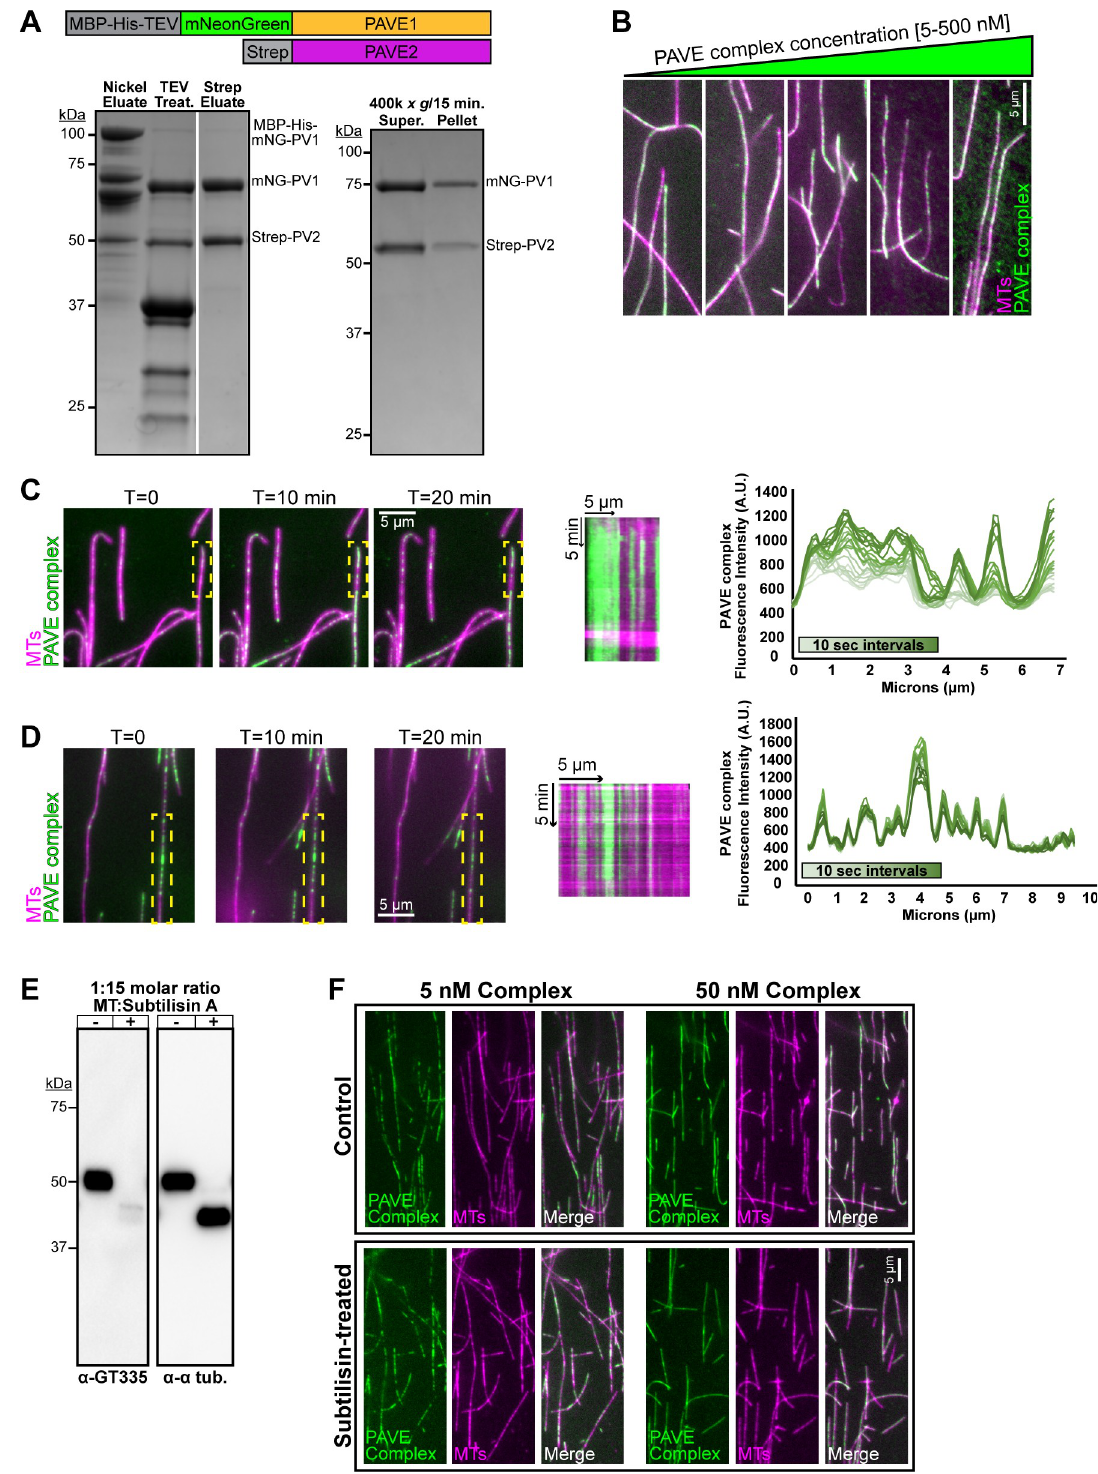
Fig 6. PAVE1 and PAVE2 form a complex in vitro that binds the microtubule lattice. (A) (Left) Coomassie-stained SDS-PAGE gel demonstrating the co-purification of mNeonGreen-PAVE1 and Strep-PAVE2 from E . coli cells. E . coli cells co-expressing [MBP- oligoHis 10 -TEV]-mNeonGreen-PAVE1 and Strep-PAVE2 constructs were harvested, lysed, and the clarified supernatant was batch- bound with Ni-NTA resin. The eluate was treated with TEV protease and allowed to interact with Strep-Tactin XT resin. Proteins were